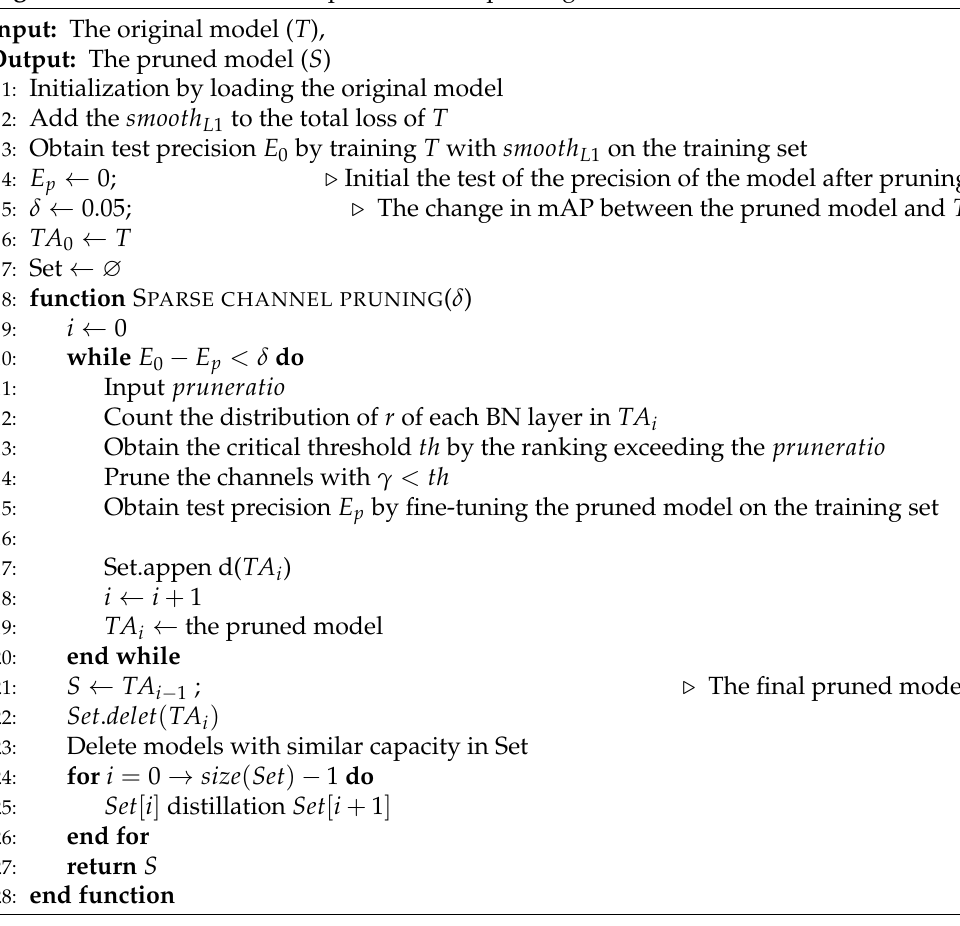
Figure 1. Compression architecture based on sparse channel pruning and assistant distillation. The intermediate model retained in the iterative pruning process serves as the assistant model. The precision of the model is restored after pruning by the way of the teacher’s distillation of the assistant and the assistant’s distillation of the student. Algorithm 1 Procedure of the sparse channel pruning + assistant